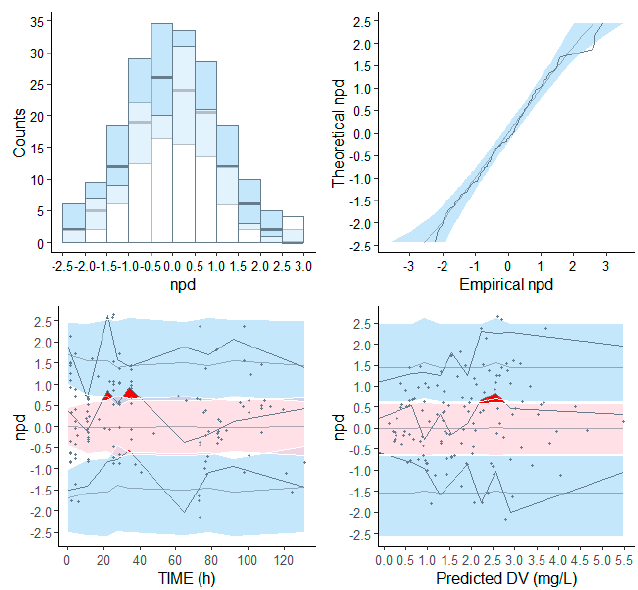
Figure 3. Visual output of the normalized prediction distribution error (NPDE) analysis. Shown at the top are the QQ plot and histogram of the NPDEs in the overall dataset. The red dotted line and blue shaded areas show the expected trends and 95% confidence intervals of these trends, while the dark blue lines and bars show the observed NPDE distributions. At the bottom, the individual NPDE values for each observation are plotted versus time and versus the predicted concentrations with the symbols. The solid lines in the bottom graphs indicate the mean (red) and the 95% percentiles (blue) of the NPDEs, and the shaded areas are the simulated 95% confidence intervals of the NPDE median (red) and 95% percentiles (blue), while the dotted red and blue lines show the expected values for the median and 95% percentiles.